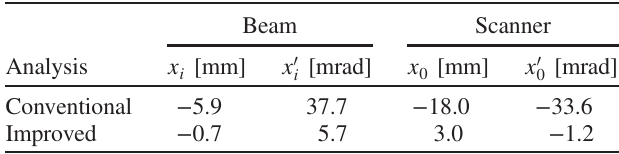
TABLE VI. Beam parameters of corresponding to the phase 1000 V in Fig. 12, computed with space distribution at V Q 3 ¼ and without correction terms.